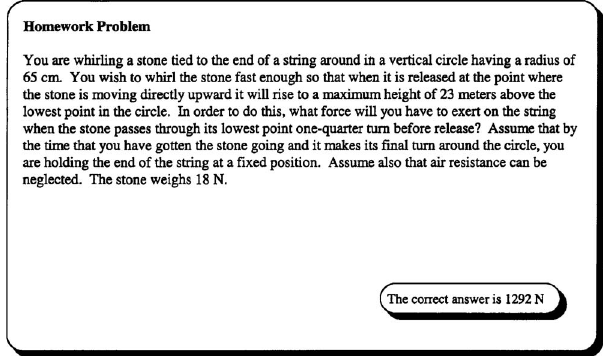
FIG. 1. “Core problem” that instructors were asked to solve prior to the